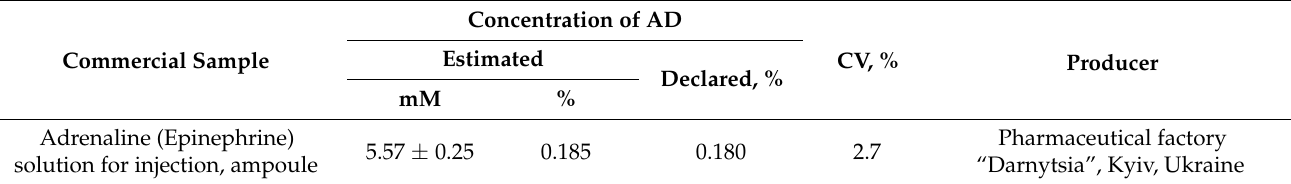
Table 3. Results of AD estimation in pharmaceutical “Adrenaline”.